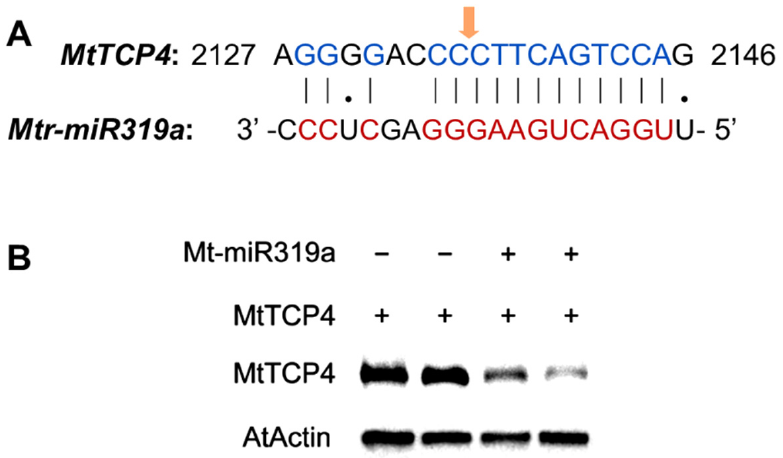
Figure 7. Prediction and verification of the cleavage of MtTCP4 , the target gene of Mtr-miR319a : prediction of the cleavage of MtTCP4 as the target gene of Mtr-miR319a ( A ); verification of the cleavage of MtTCP4, the target gene of Mtr-miR319a , by Western blot ( B ). The orange arrow in ( A ) indicates the site where the target gene was cleaved by Mtr-miR319a .